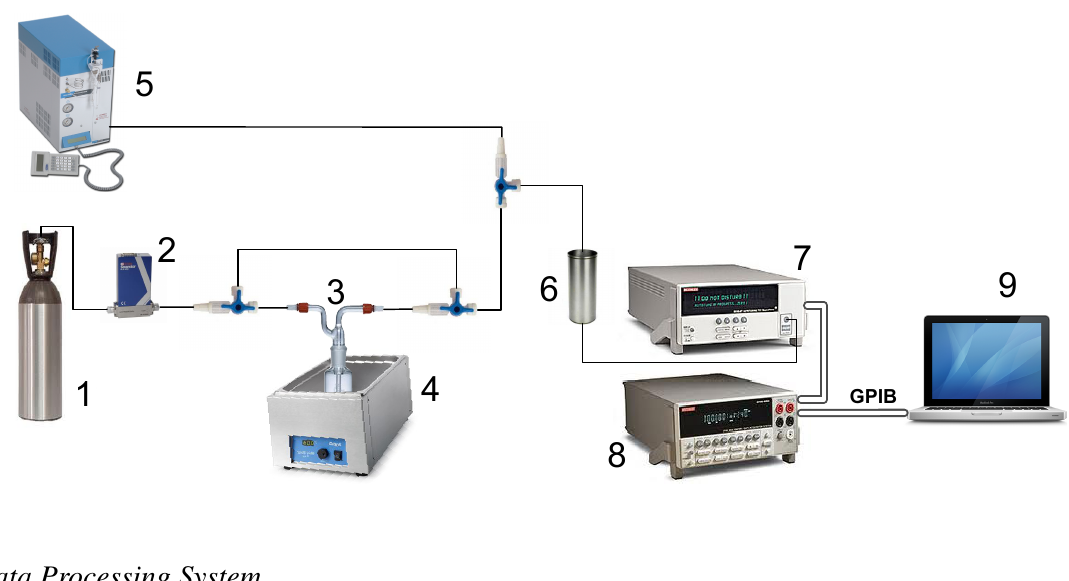
Figure 3. Measurement setup: 1. Nitrogen bottle; 2. Mass Flowmeter Controller; 3. Dreschel bottle with sample; 4. Thermostatic bath; 5. Tekmar 3100 purge and